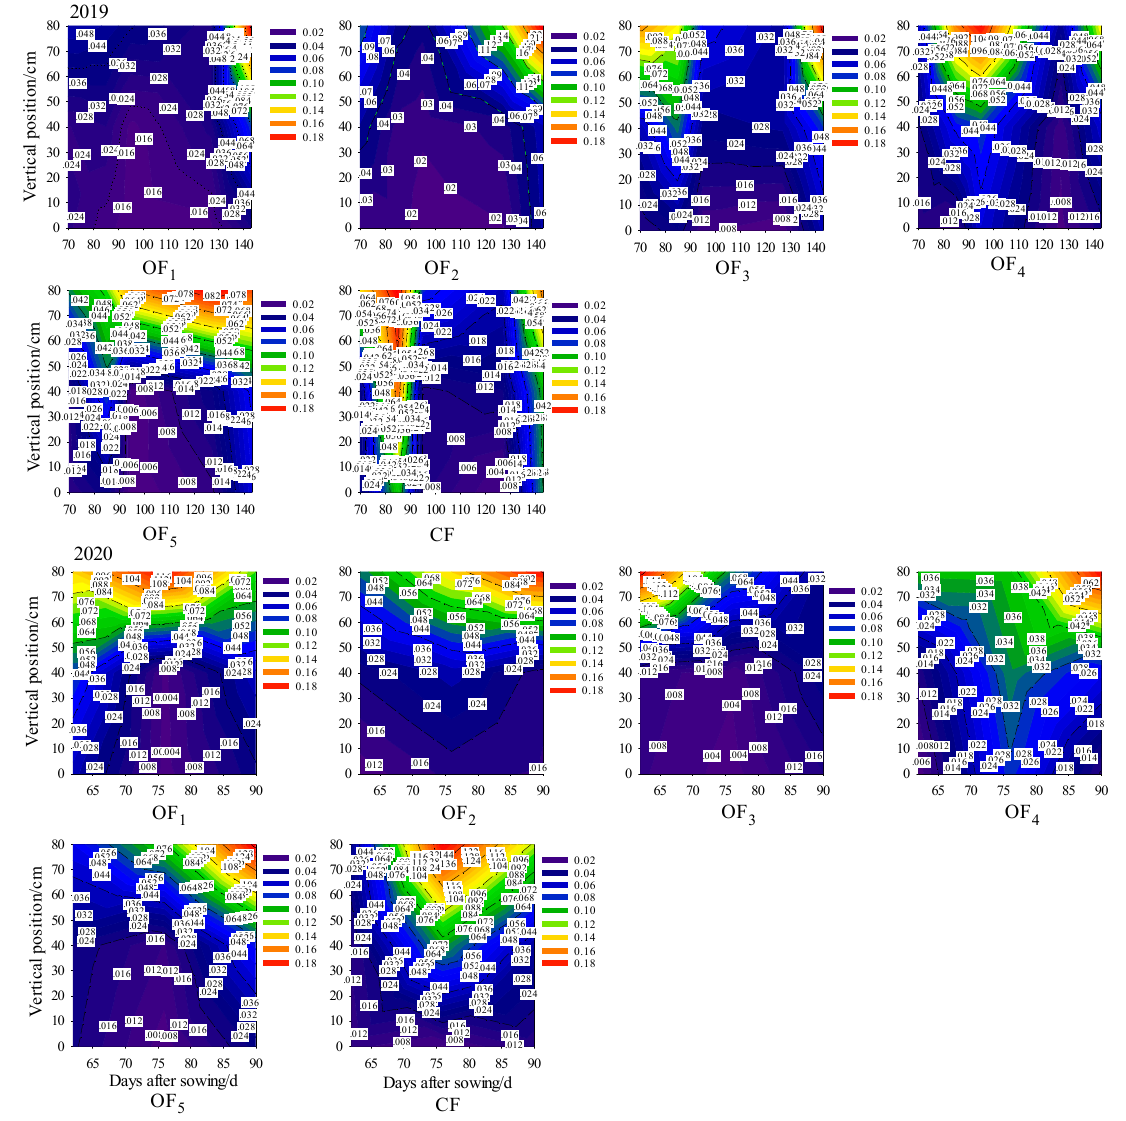
Figure 6. Effect of organic liquid fertilizer combined with different ratios of chemical fertilizers on the cotton canopy. The numbers of legend from 0.02 to 0.18 indicate vertical-position canopy light transmittance.